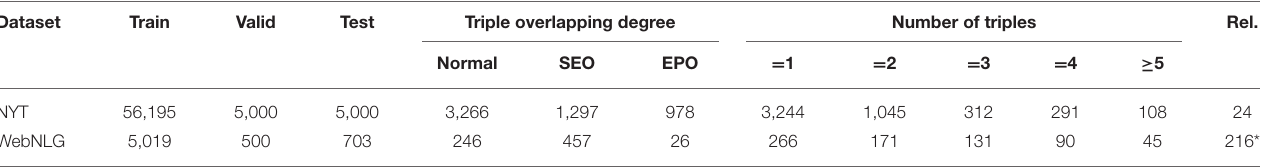
TABLE 2 | Statistics of